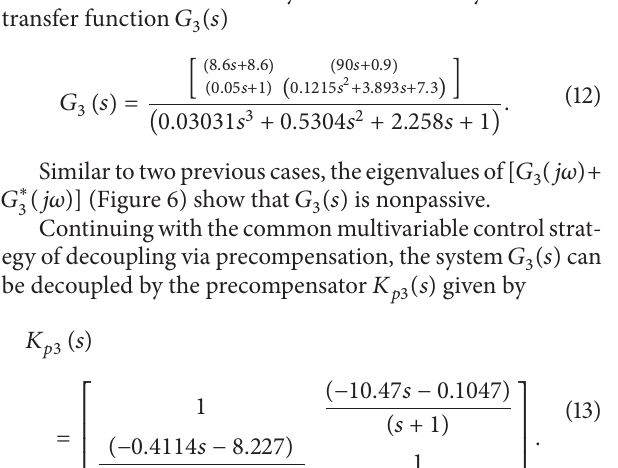
Figure 4: Eigenvalues of [𝐺 𝑝2 (𝑗𝜔) + 𝐺 ∗ 𝑝2 (𝑗𝜔)] (Case 2 ).